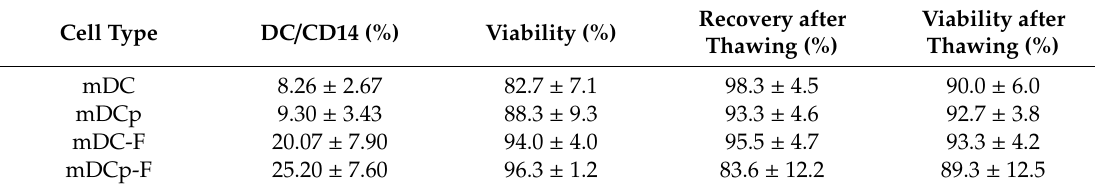
Figure 1. Morphological characterization of dendritic cells (DC). Images are from light microscopy at 20 × magnification. Fast-DC cultivated in absence of PGE 2 ( a ) resulted strongly adherent to culture surface respect to Fast-DC cultivated with PGE 2 ( b ). Adherent cells are evident and point out by arrows in 40 × magnification image (A). Pictures ( c , d ) represent standard method DC respectively without PGE 2 and with PGE 2 . The absence of PGE 2 results in higher percentage of adherent cells also in the standard method. Table 1. Comparison of total cell yield, cell viability, recovery and viability after thawing of DC from Fast and standard methods.